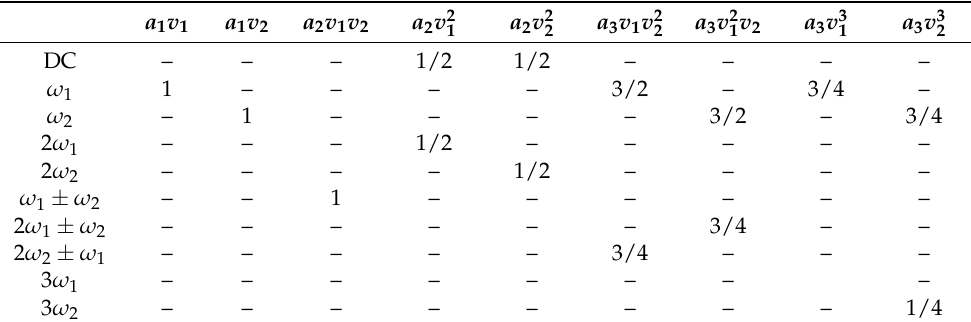
Table 6. Nonlinear coefficients of harmonic and intermodulation